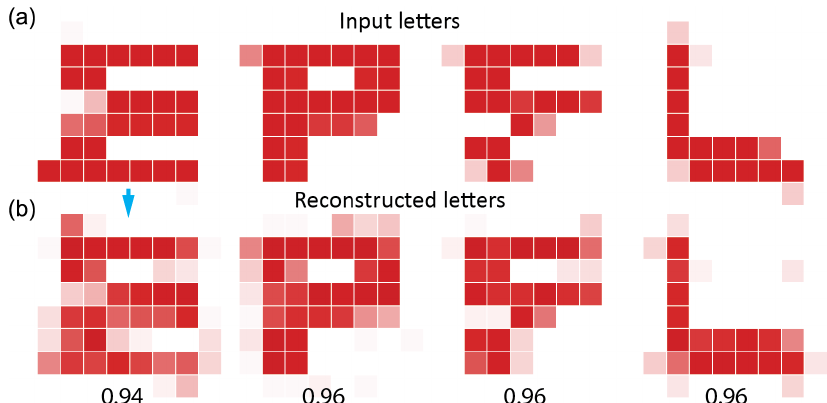
FIG. 5. Subwavelength image reconstruction using the transfer-learning technique. UCNN initially trained on the 0 – 9 digits is retrained on a small set (600 training and 200 test samples) of letters ( “ E , ” “ P , ” “ F , ” and “ L ” ) and then used to reconstruct the letters that it did not see before. (a) Initial test letters drawn on an ( 8 × 8 )-speaker lattice. (b) Reconstructed letters using retrained UCNN, which are practically identical to the target letters, demonstrating the great versatility of the DNN approach to recognize any image using the transfer-learning technique. The correlation coefficient between each reconstructed image and its corresponding target image is shown at the bottom of the